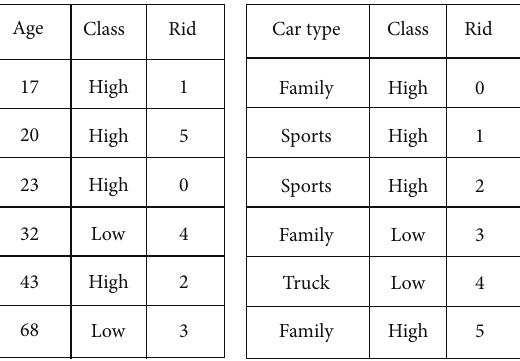
Figure 2: Sample of SPRINT attributes